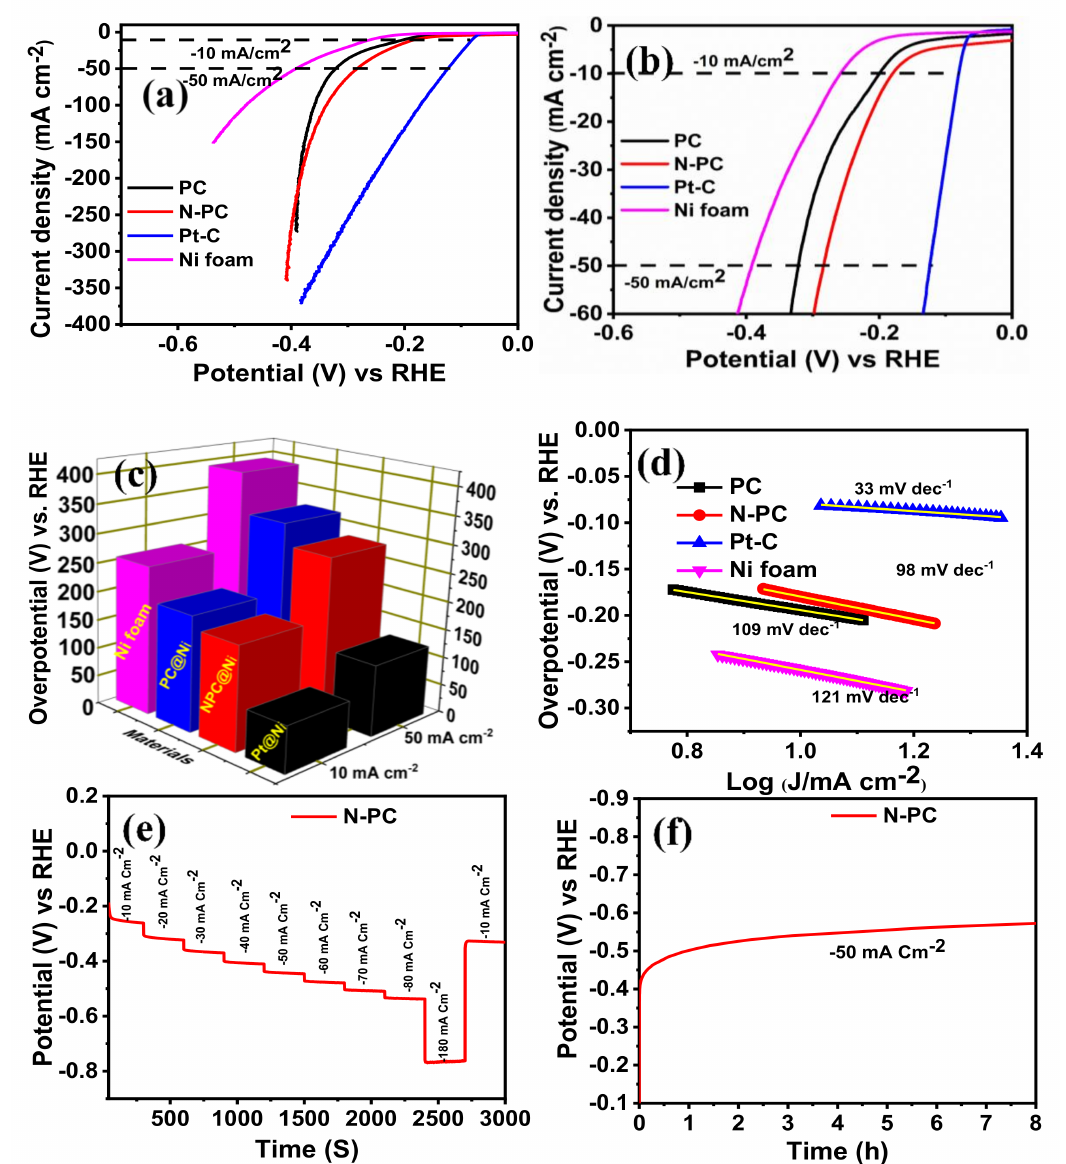
Figure 9. ( a , b ) Hydrogen evolution reaction (HER)-LSV curve of PC@Ni, N-PC@Ni, Pt-C@Ni, and Ni foam in 1 M KOH solution at a scan rate 1 mV s − 1 [with iR-correction]; ( c ) bar of prepared catalyst vs overpotential at 10 and 50 mA cm − 2 ; ( d ) Tafel slopes of PC@Ni, N-PC@Ni, Pt-C@Ni and Ni foam; ( e ) multiple-step chronopotentiometric of N-PC@Ni; ( f ) chronopotentiometric curve of N-PC@Ni at a constant of − 50 mA cm −